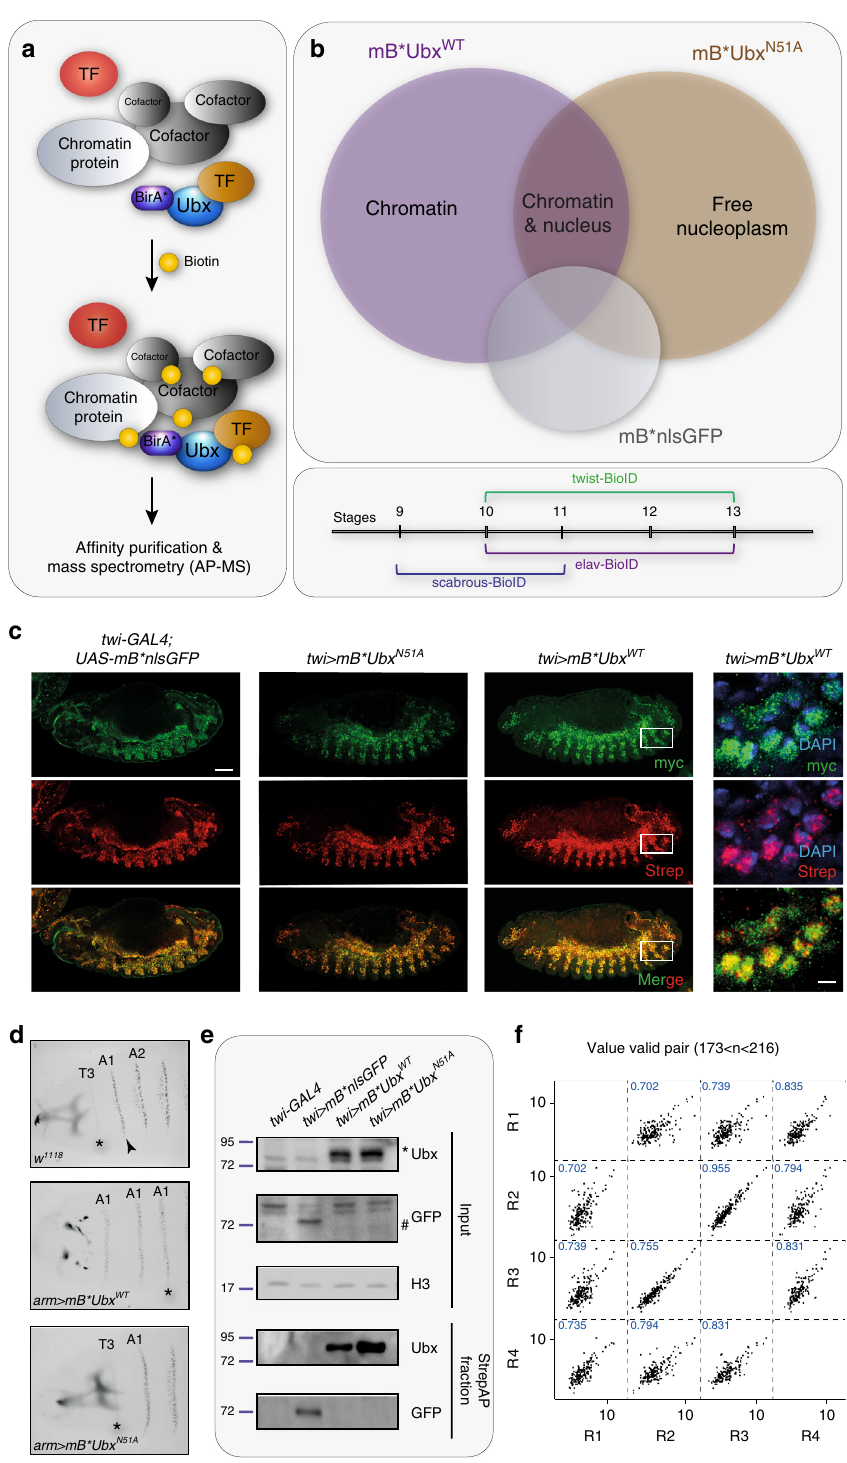
We fi rst evaluated the tissue-speci fi c expression of the mB * fusion proteins and their activity by immuno fl uorescence. This analysis revealed a robust and speci fi c expression and biotinylation ef fi ciency of the BirA * fusion proteins (Fig. 1c, Supplementary Figs. 2b – d, 3a, b). In contrast, we did not detect any biotinylation in wild-type embryos (Supplementary Fig. 2a). These results demonstrated that the yeast-rich food diet used for the experiments was suf fi cient for BirA * dependent protein biotinylation in Drosophila embryos, rendering